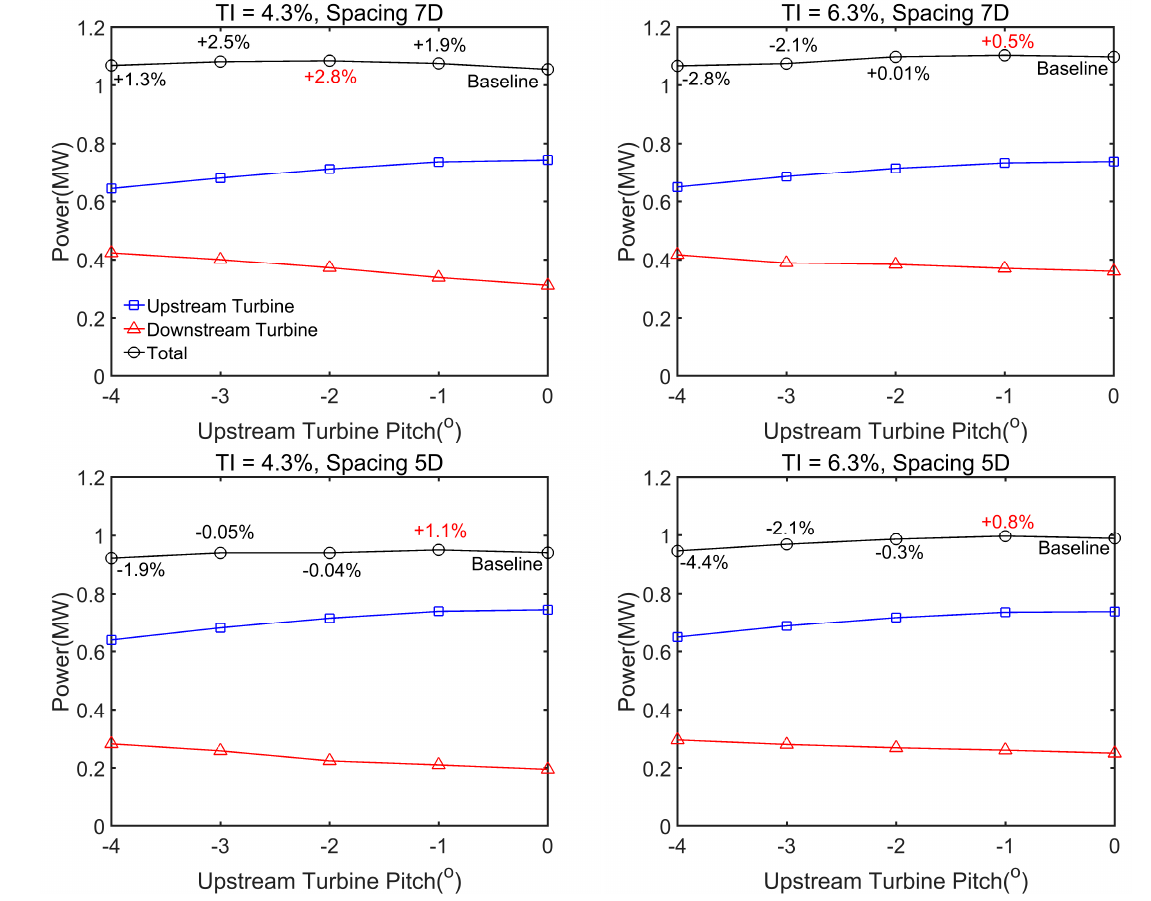
Figure 8. Variation of combined power of the two turbine configuration with pitch offset for upstream turbine for two turbulence levels (4.3% and 6.3%) and two inter-turbine distances (5 D and 7 D).